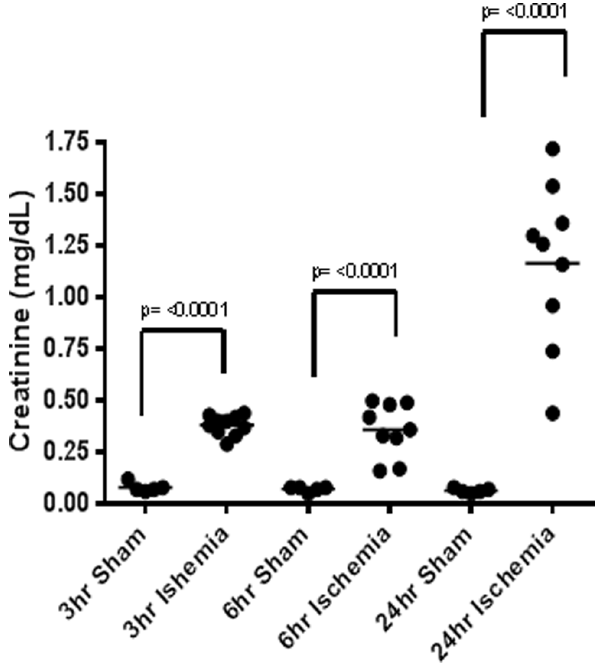
Figure 3 . Changes of plasma creatinine in the time course of renal ischemia-reperfusion. Creatinine is a conventional circulating marker that is elevated when the kidney excretory function is impaired. In the sham-operated mice, plasma creatinine levels were at or below detection, while they were significantly increased in the animals that underwent bilateral renal ischemia-reperfusion. Plasma creatinine levels progressively grew over the time of reperfusion. Time points on the graph represent the time of